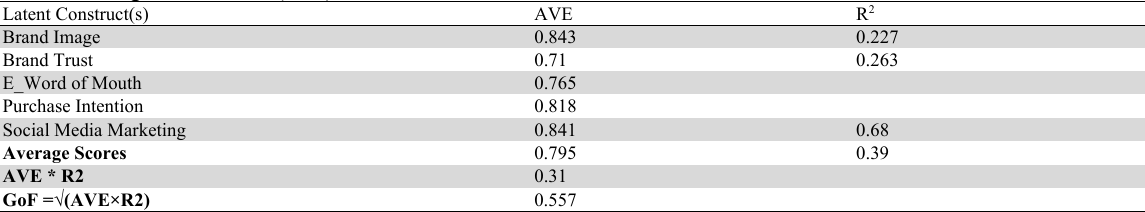
Calculation of goodness of fit (GoF)